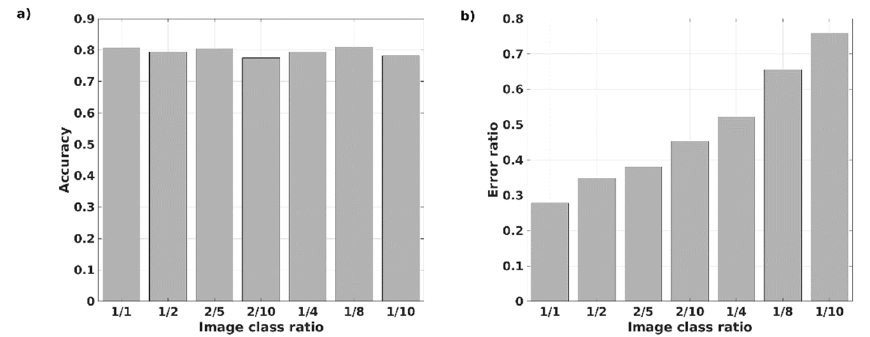
Figure 6. ( a ) Accuracy vs. Image class ratio. ( b ) Error ratio vs. Image class ratio.